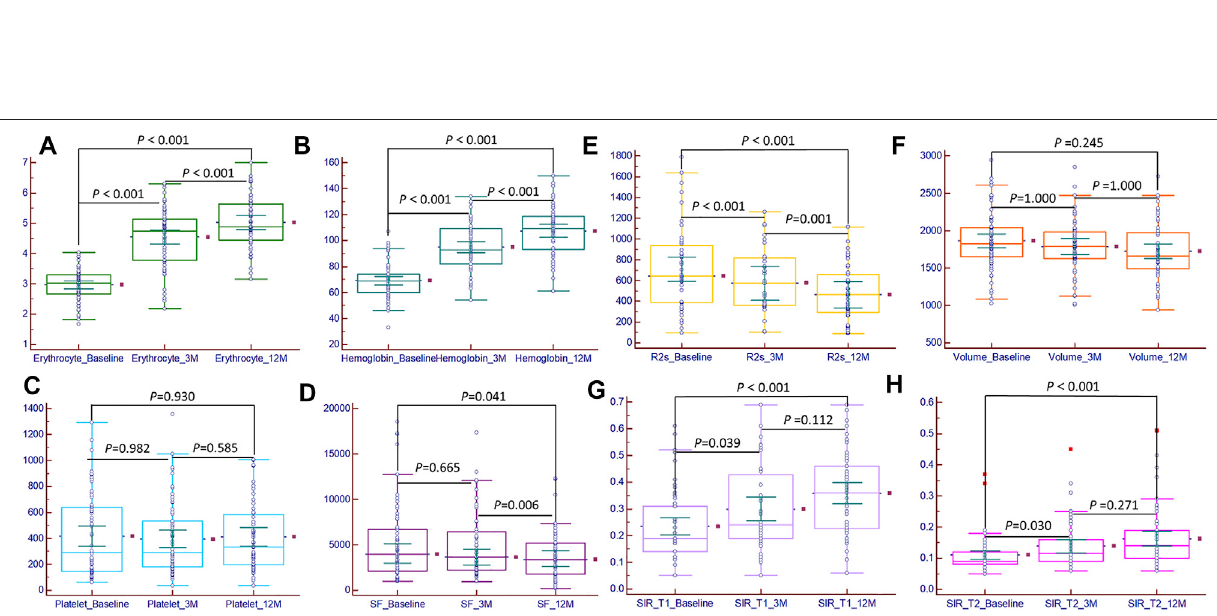
Frontiers in Pharmacology |